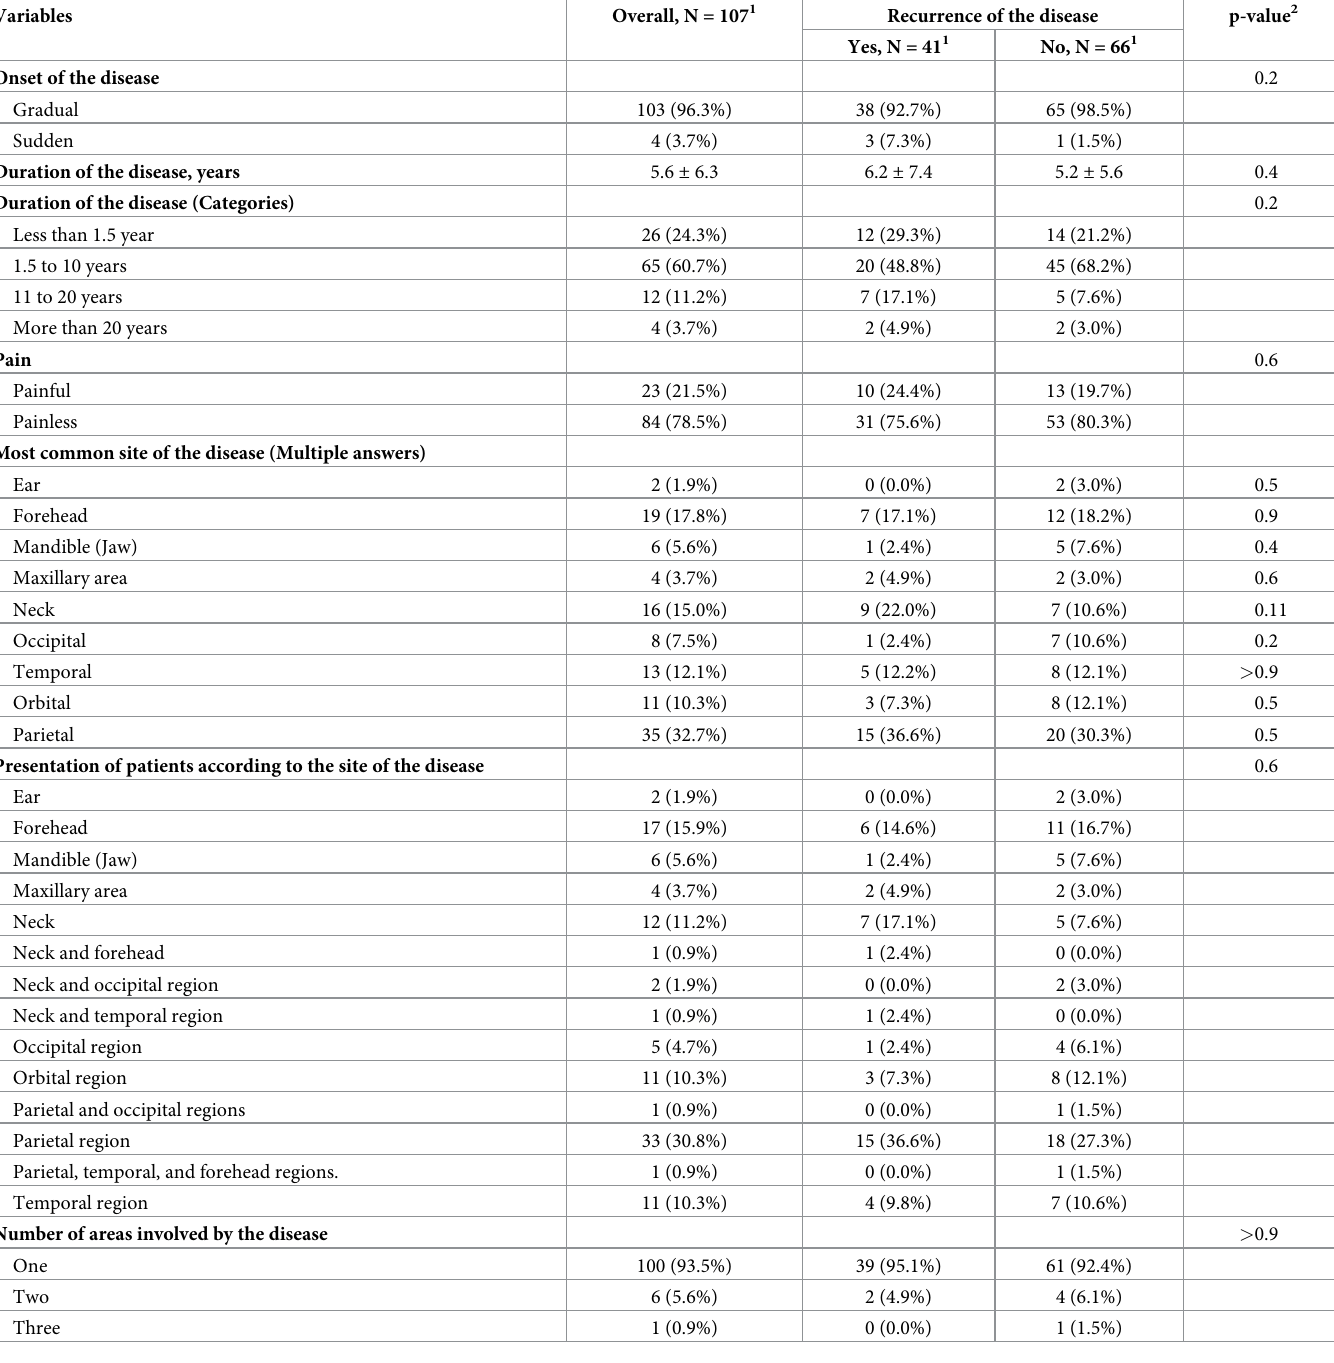
Table 2. Clinical course and duration of the disease among participants. (n =